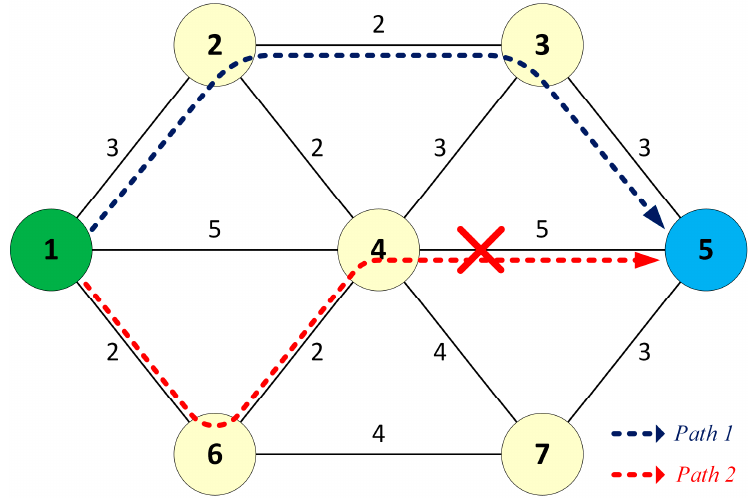
Figure 3. Fault-tolerant communication in the failure case.